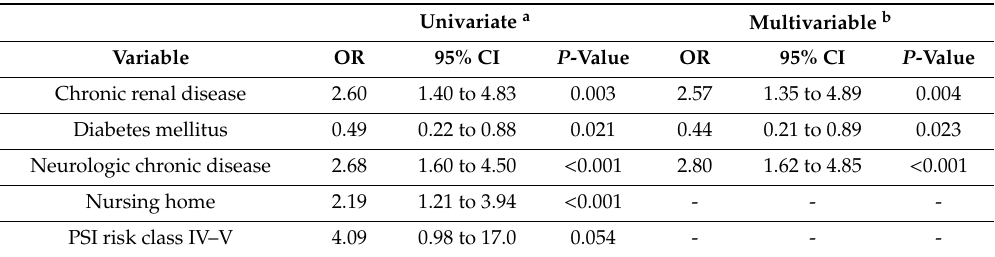
Table 4. Significant risk factors for 30-day mortality in patients with sepsis in weighted logistic regression analyses ( n =